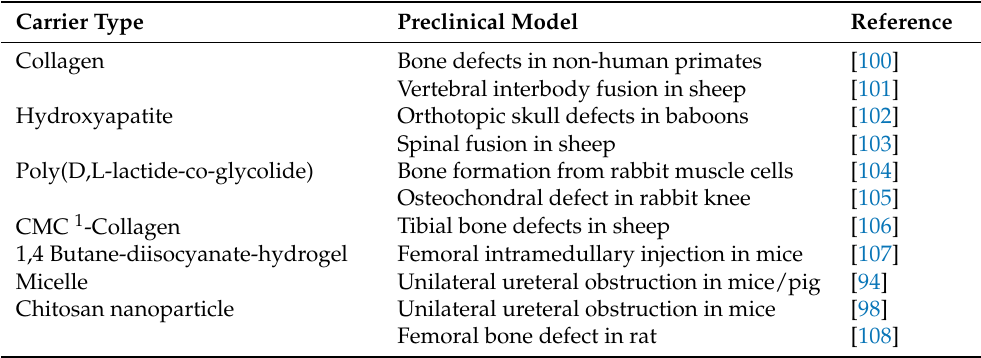
Table 2. Overview of studies for enhancing BMP-7 delivery employing various